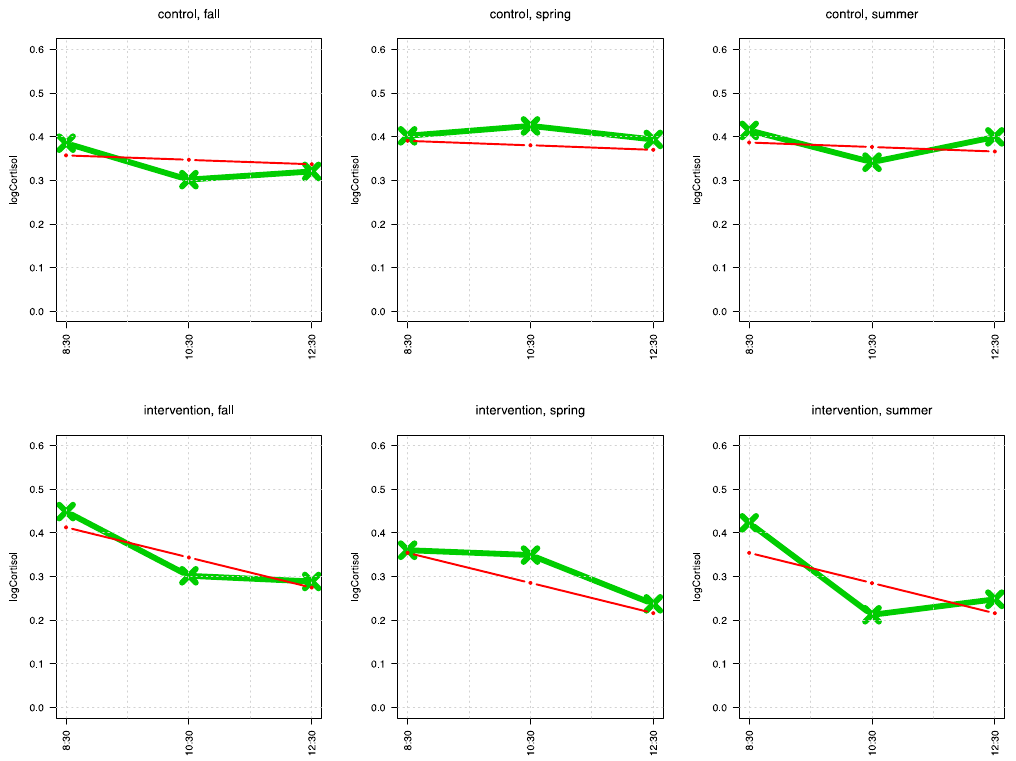
Figure 2. Displayed are the running curves of logCortisol over the day in each season for both groups. The upper panels show the CG values, the lower panels IG values. The green line represents the mean values, the red line connects the calculated values of least squares regression. It can be seen that IG shows, in contrast to CG, a clear decrease of cortisol levels in the course of the school days, but not the CG ( p = 0.009).